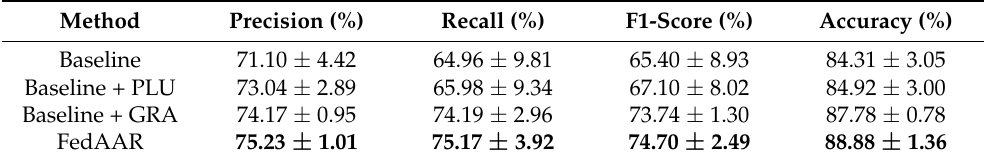
Table 3. Evaluation results (mean ± std) of the GRA and PLU modules on classification performance. The best results for each metric are highlighted in bold.